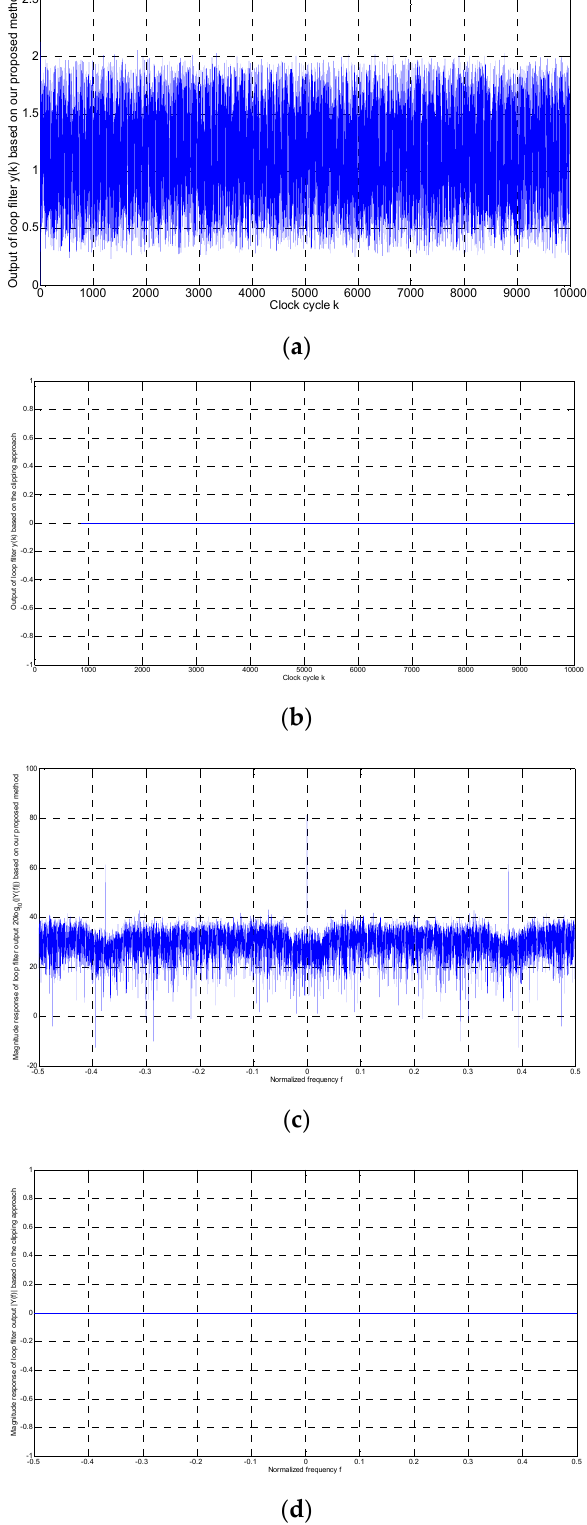
≥ k = ku for 0 under our proposed control ≥ k = ku for 0 under the clipping strategy ≥ k = ku for 0 under